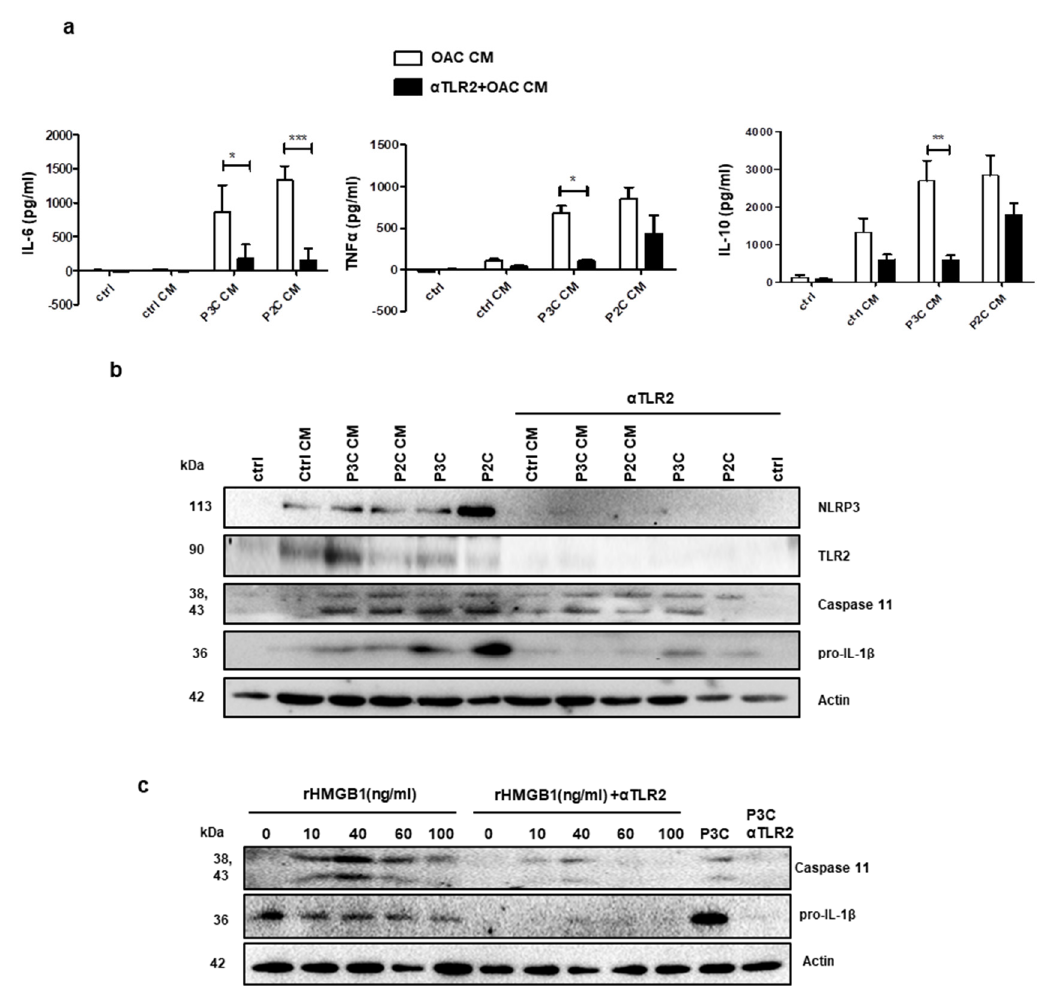
Figure 6. Conditioned media from oesophageal cancer cells induce TLR2-dependent cytokine secretion and upregulation of inflammasome-related proteins in macrophages. ( a ) IL-6, TNF α and IL-10 levels in BMDM supernatants pre-treated with ctrl, P3C- and P2C-CM were determined by ELISA. Values represent the mean ± SEM of n = 3; * p < 0.05; ** p < 0.01; *** p < 0.001 (two-way ANOVA test). ( b ) BMDMs were left untreated or pre-treated with α TLR2 (10 µg/mL) for 1 h prior to stimulation (24 h) with 50% CM collected from unstimulated (ctrl CM), P3C- or P2C-stimulated (0.05 µg/mL) SK-GT 4 cells; or directly with P3C or P2C (0.05 µg/mL) as positive control. The expression of NLRP3, TLR2, caspase-11, pro-IL-1 β and actin (loading control) were determined by Western blot. ( c ) BMDMs were left untreated or pre-treated with α TLR2 (1 h, 10 µg/mL) prior to stimulation (24 h) with recombinant HMGB1 (10–100 ng/mL). Caspase-11, pro-IL-1 β and actin (loading control) levels were determined by Western Blot. Blots are representative of three independent experiments.